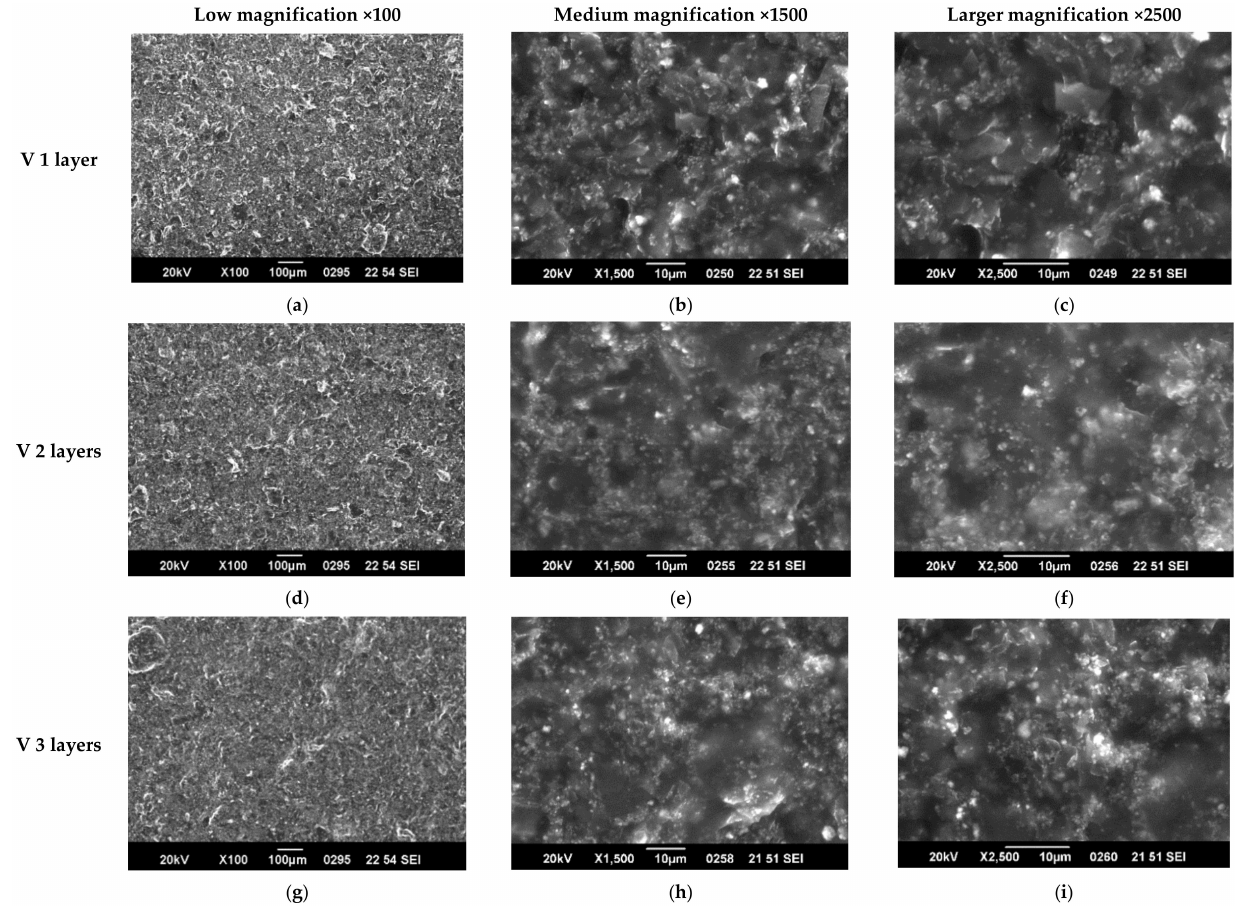
Figure 4. SEM characterization of 1, 2 and 3 layers of paint V at different magnifications. ( a ) ( i ) V3 ×